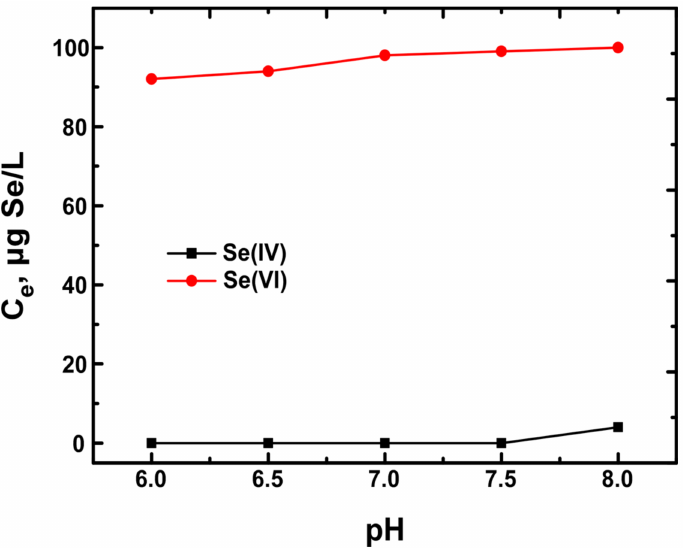
Figure 1. Effect of pH on adsorption of Se(IV) and Se(VI) species (examined separately), using FeOOH as adsorbent (synthesized at pH 2.5). Experimental conditions: initial concentration is 100 µ g Se(IV)/L, 100 µ g Se(VI)/L, adsorbent dose 2 g FeOOH 2.5